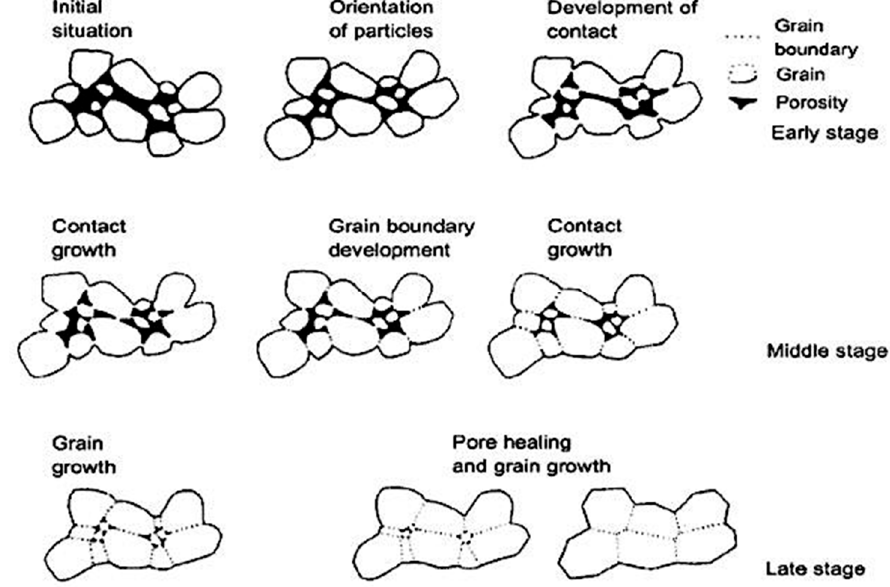
Figure 14. Grain growth during the sintering process. (Source: http://www.keramverband.de/brevier_engl/4/1/4_1_4.htm, accessed on 15 September 2022) [68].